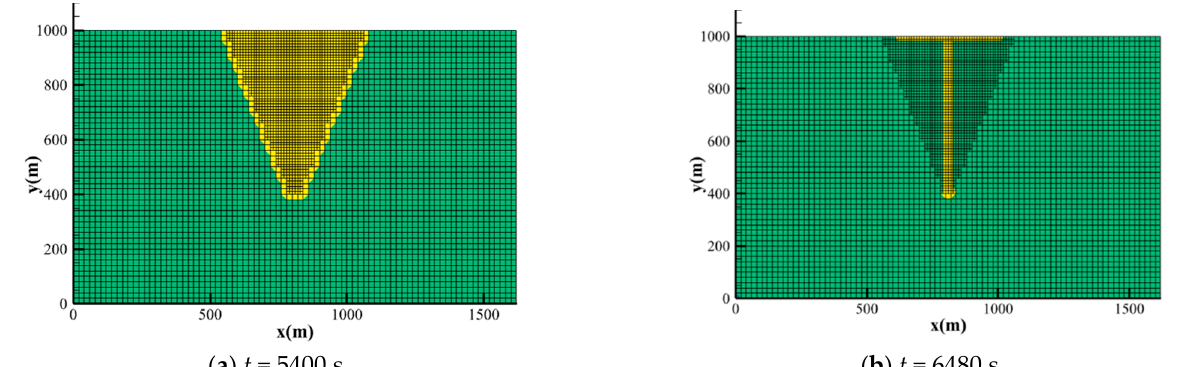
Figure 15. The position of the coupling boundary at different times.